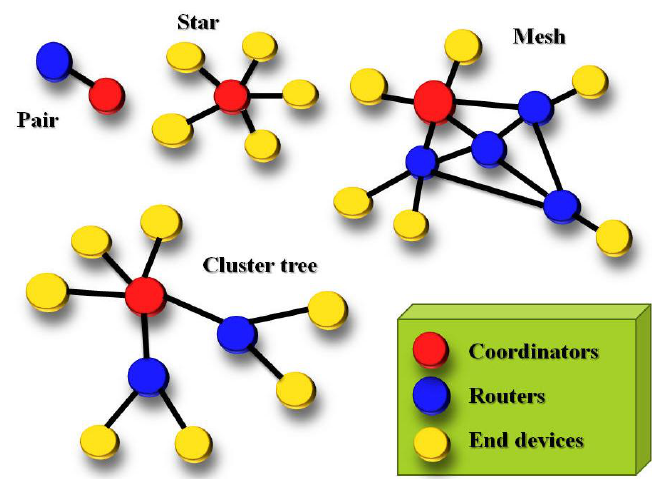
Figure 5. ZigBee network topology.